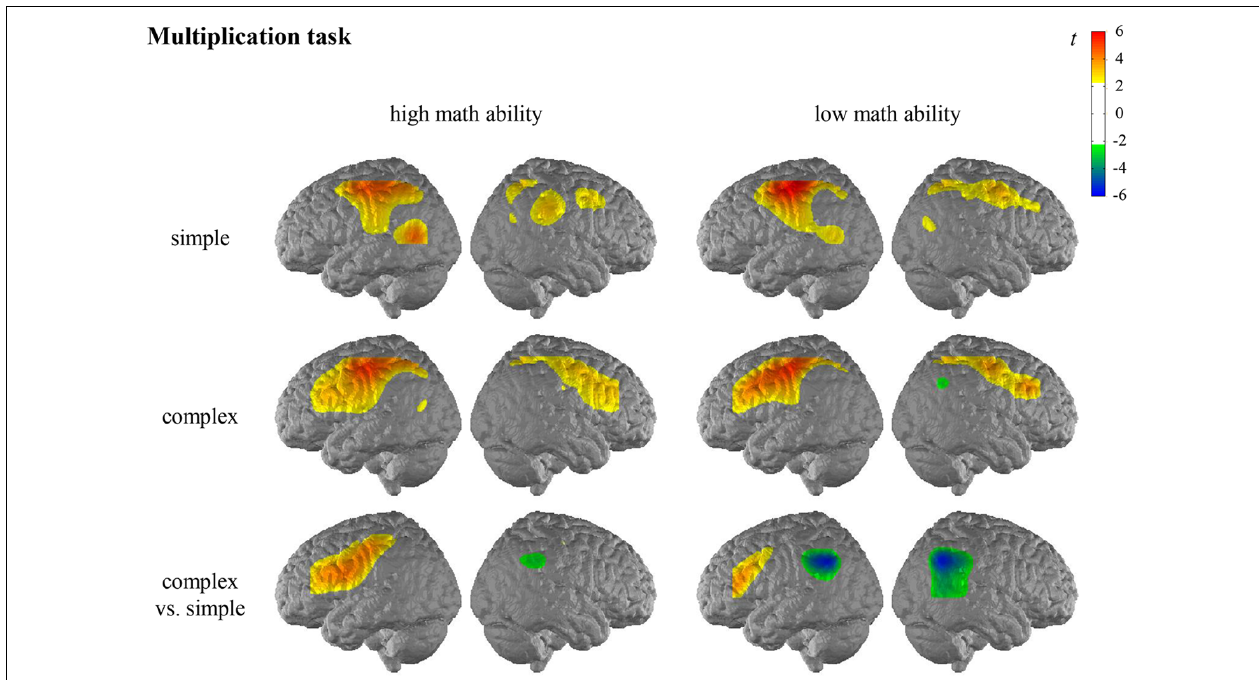
FIGURE 2 | T maps for the functional near-infrared spectroscopy (fNIRS) data depicting neural activation during the multiplication task for simple arithmetic problems, complex arithmetic problems and the contrast (complex vs. simple) for individuals with high math ability and low math ability. The colors indicate activation (yellow-red) and deactivation (green-blue), respectively.